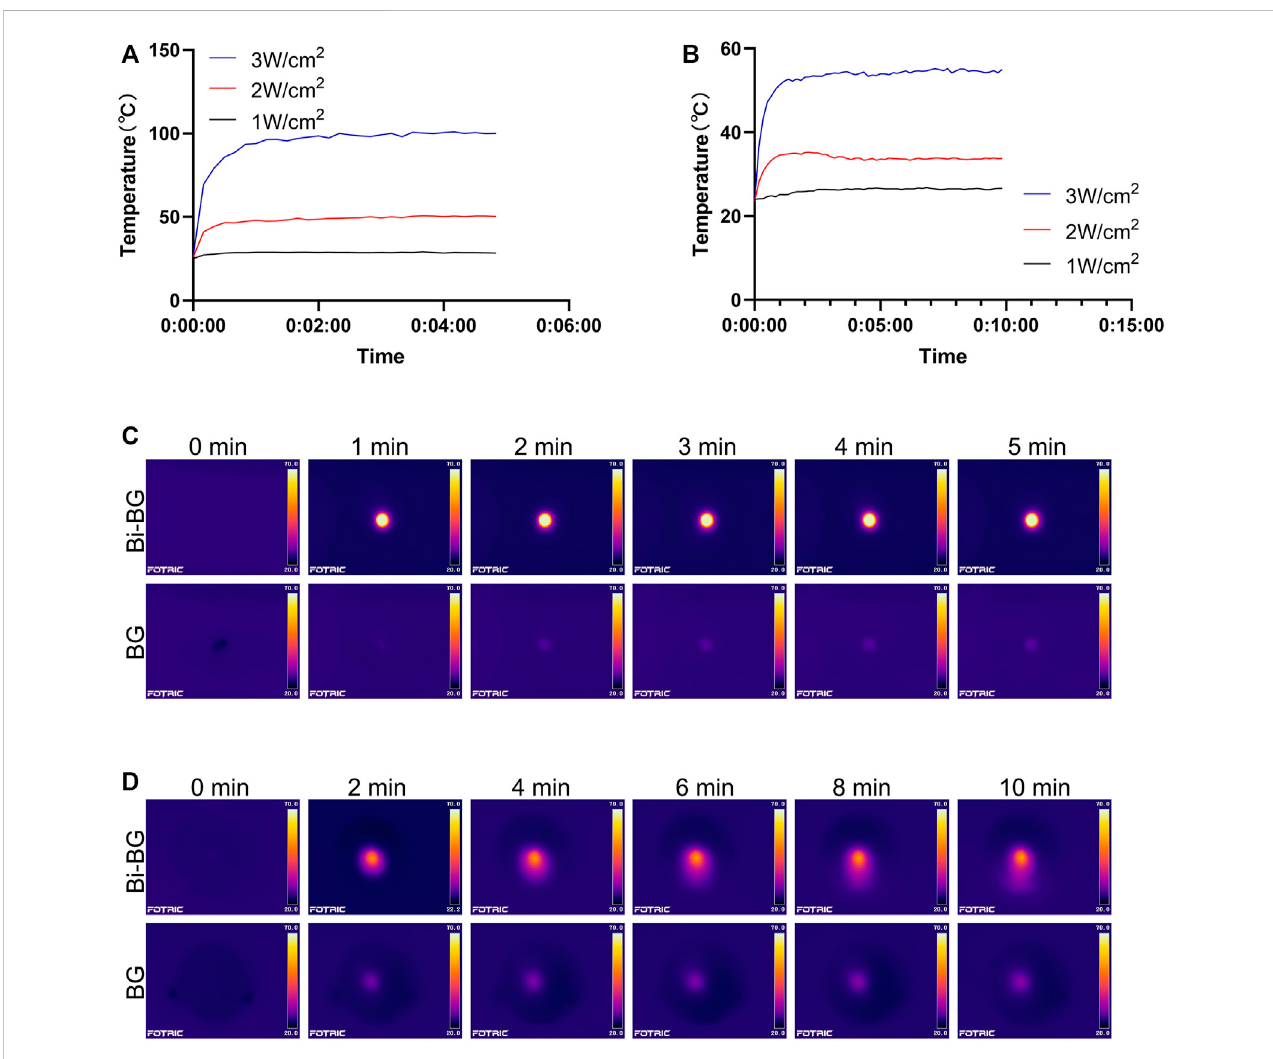
FIGURE 2 Photothermal effect of Bi-BG scaffolds. Heating curves of Bi-BG scaffolds with different laser power irradiation in (A) dry state and in (B) PBS; infrared thermal images of Bi-BG and BG scaffolds in (C) dry state and in (D) PBS under 808 nm laser